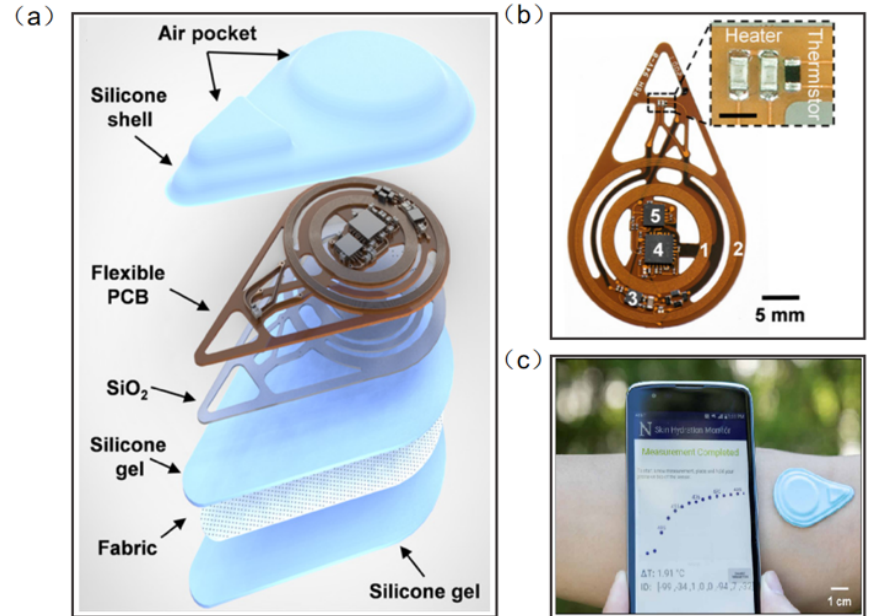
Figure 12. ( a ) Diagram illustrating the layers and components of the device [116]. ( b ) Photograph of a fully assembled flexible printed circuit board for the device [116]. ( c ) The exploded view of the device. Sensors on smartphones provide visualization of actual measurements [116]. Reprinted with permission from Ref. [116]. Copyright© 2022, The American Association for the Advancement of Science..